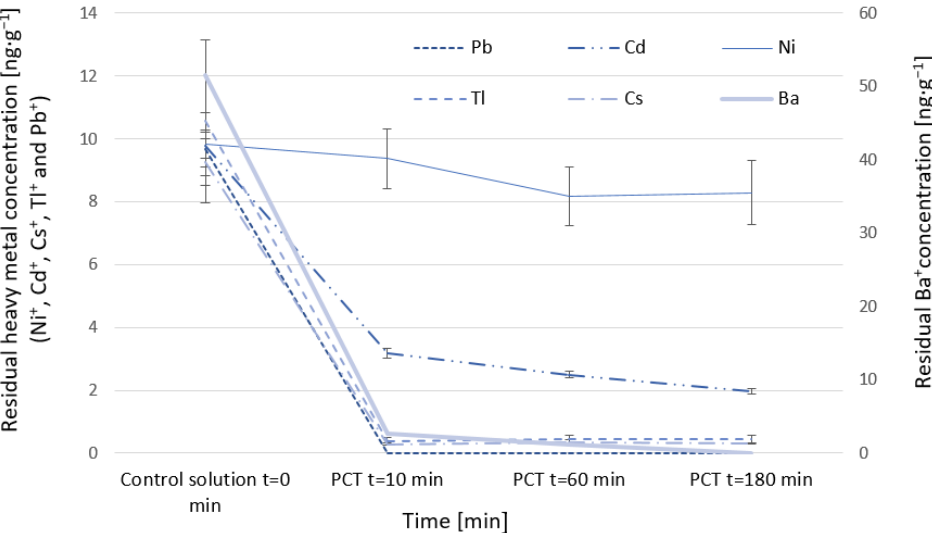
Figure 2. Adsorption kinetics of heavy metal ions onto purified clinoptilolite tuff (PCT) for concentrations of 10 ng·g −1 for Ni + , Cd + , Cs + , Tl + , and Pb + and 50 ng·g −1 for Ba + . For reaction times longer than 10 min, the lead content was below the limit of quantification (<LOQ). The figure is based on the data presented in Tables 3 and 4.